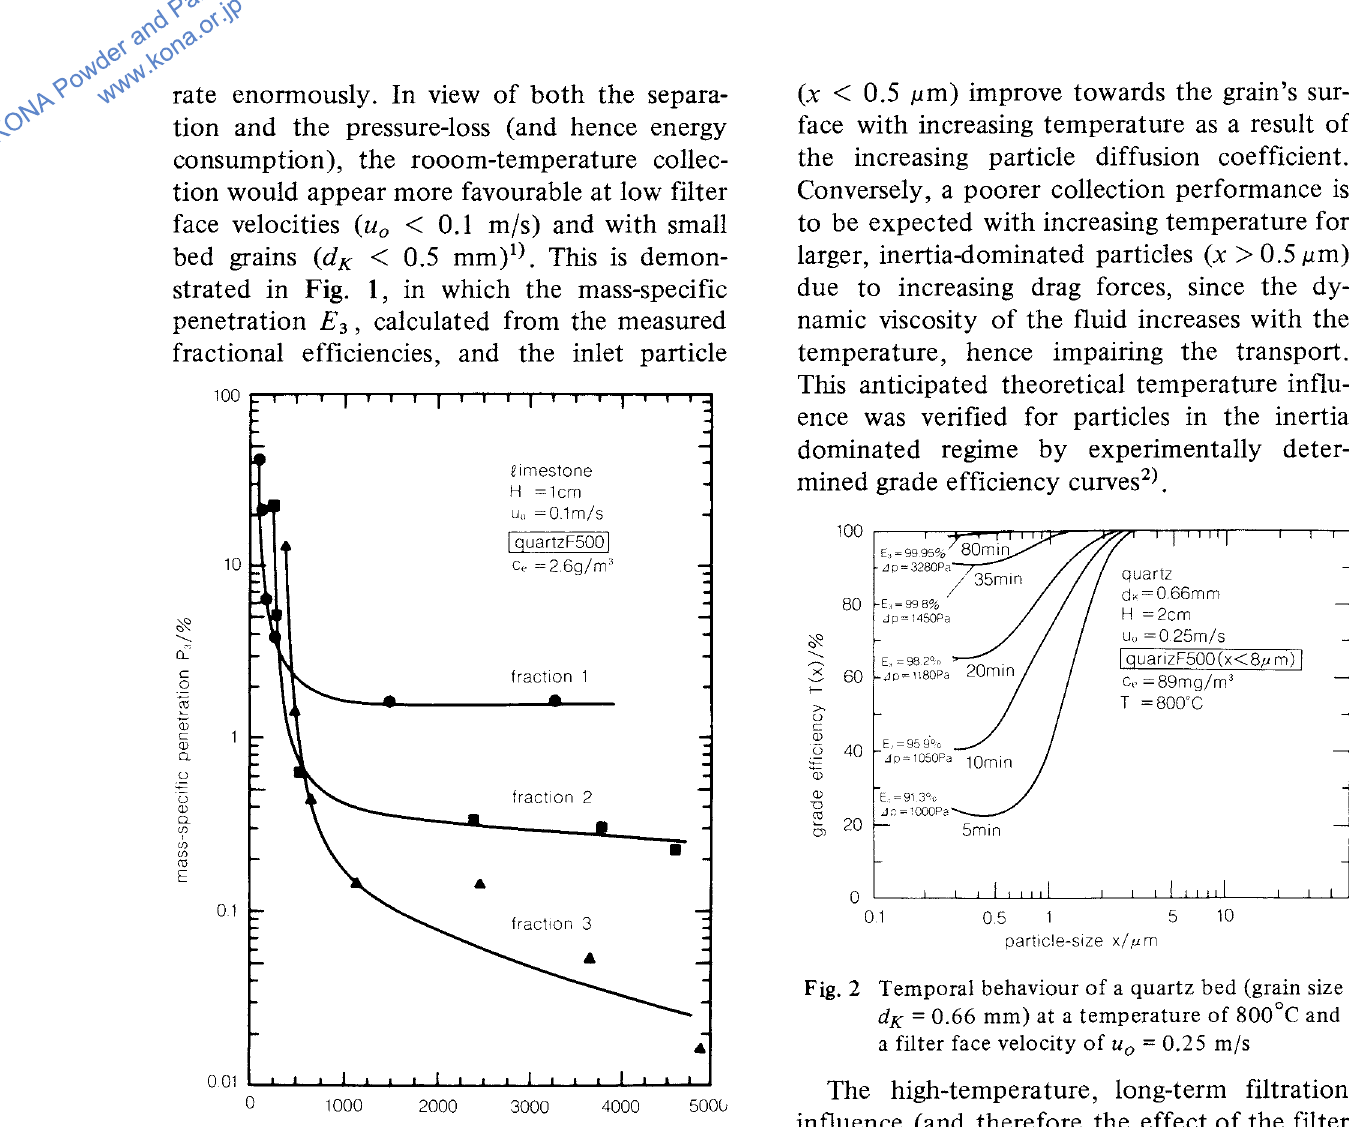
Fig. 2 Temporal behaviour of a quartz bed (grain size dK = 0.66 mm) at a temperature of 800°C and a filter face velocity of u = 0.25 0